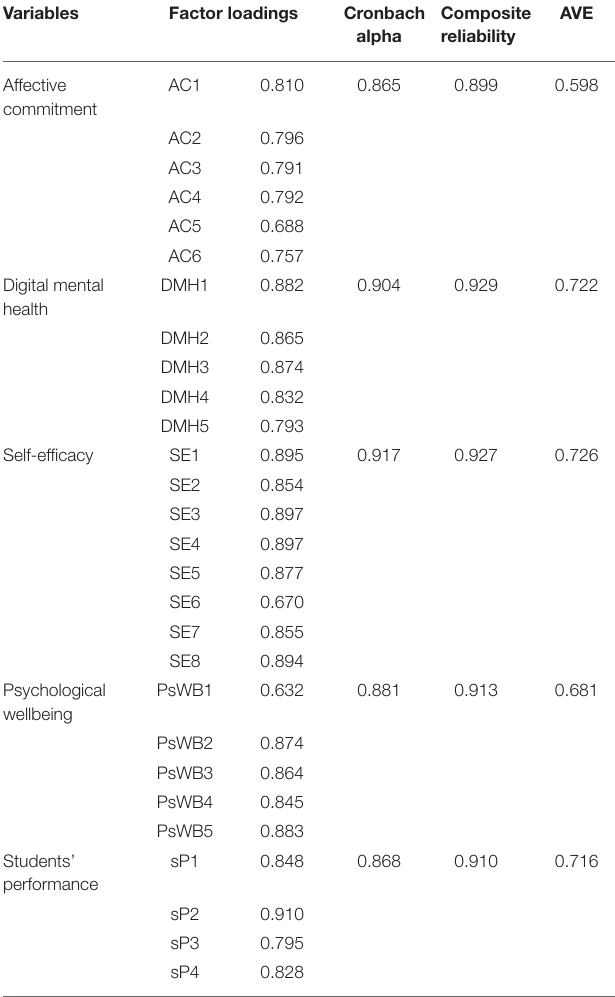
TABLE 2 | Factor loadings, Cronbach Alpha, composite reliability, and AVE. Variables